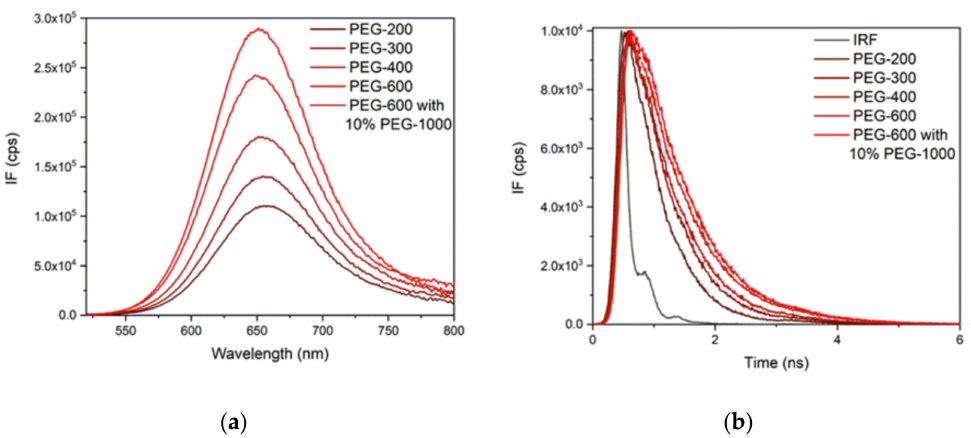
Figure 5. ( a ) Fluorescence spectra and ( b ) decay curves measured in polyethylene glycol (PEG) solutions. The spectra were measured at λ ex = 512 nm; the decay curves were recorded using a 450 nm pulsed diode